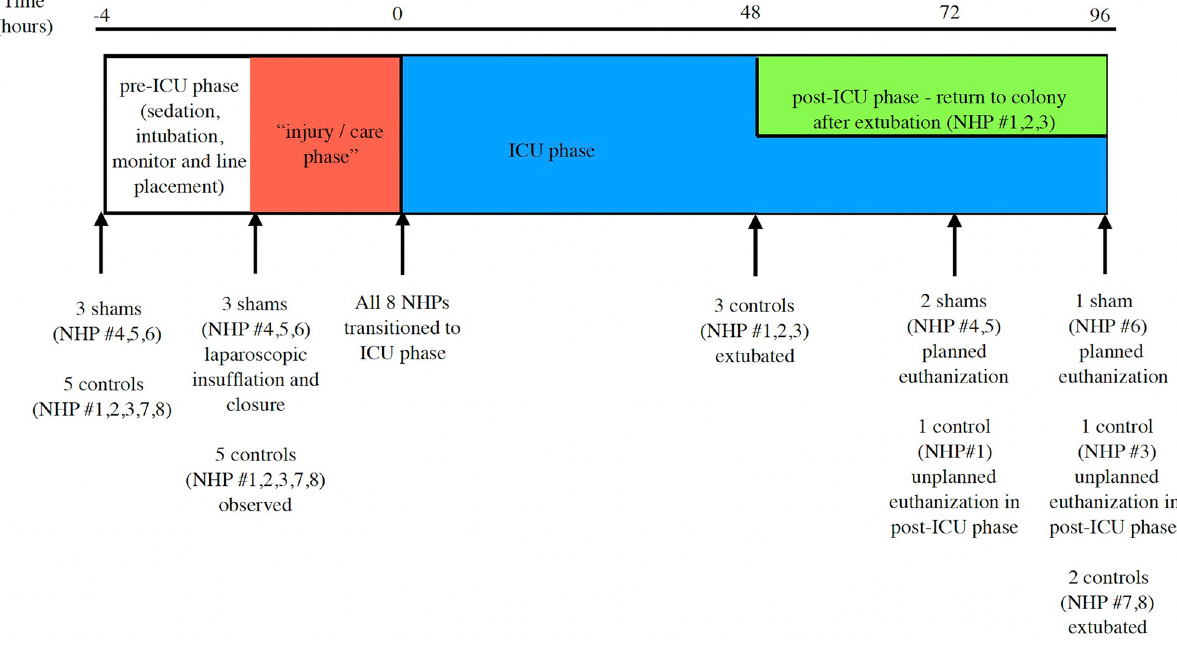
Fig 1. Time schematic of the experimental